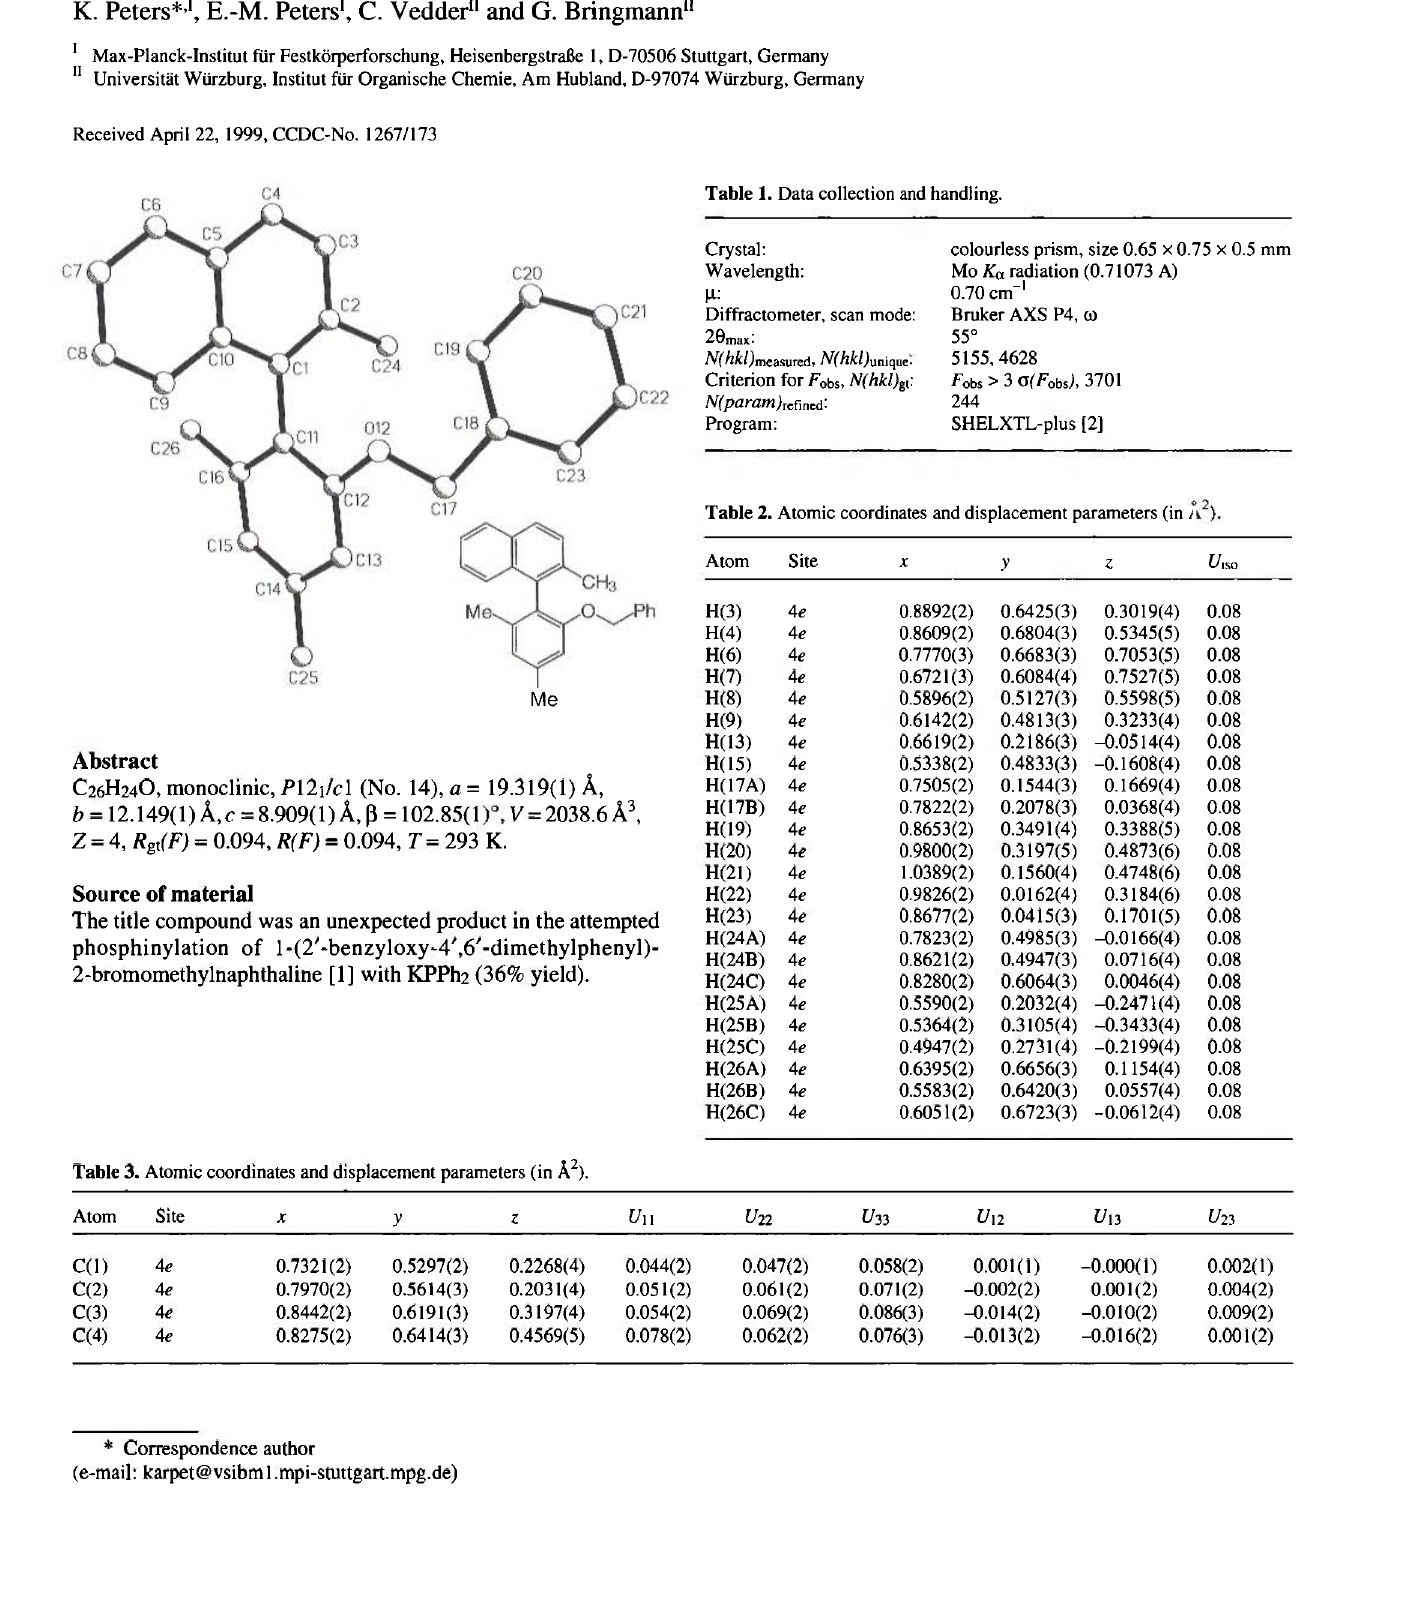
Table 1. Data collection and handling. Crystal: